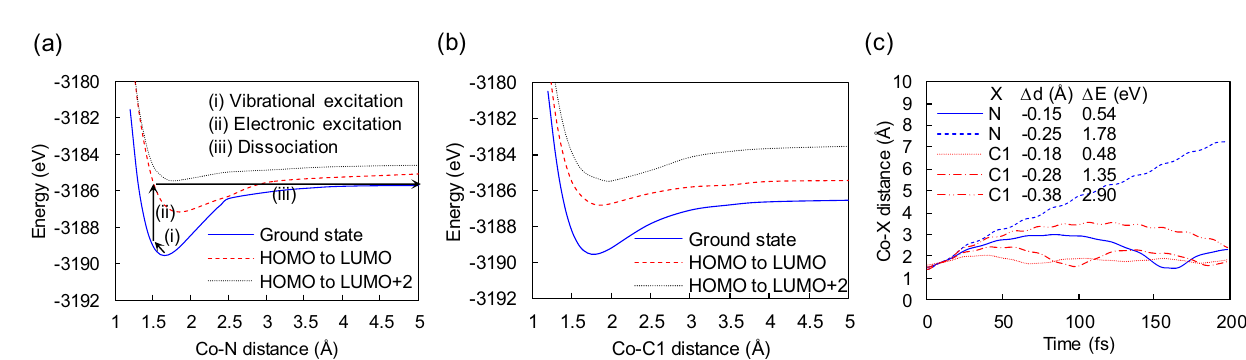
Figure 5. Ligand dissociation induced by a combination of vibrational and electronic excitations. ( a ) Adiabatic potential energy curves as functions of Co–N distance. Arrows with descriptions (i–iii) are associated with a possible pathway of Co–N dissociation induced by HOMO-to-LUMO excitation. ( b ) Adiabatic potential energy curves as functions of Co–C1 distance. ( c ) Time evolution of Co-X distance during coupled electron–ion dynamics initiated by HOMO-to-LUMO excitation. Before the excitation, Co-X distance is initially adjusted by (cid:31) d , and the molecule gains energy by (cid:31) E , which is regarded as vibrational excitation at the electronic ground